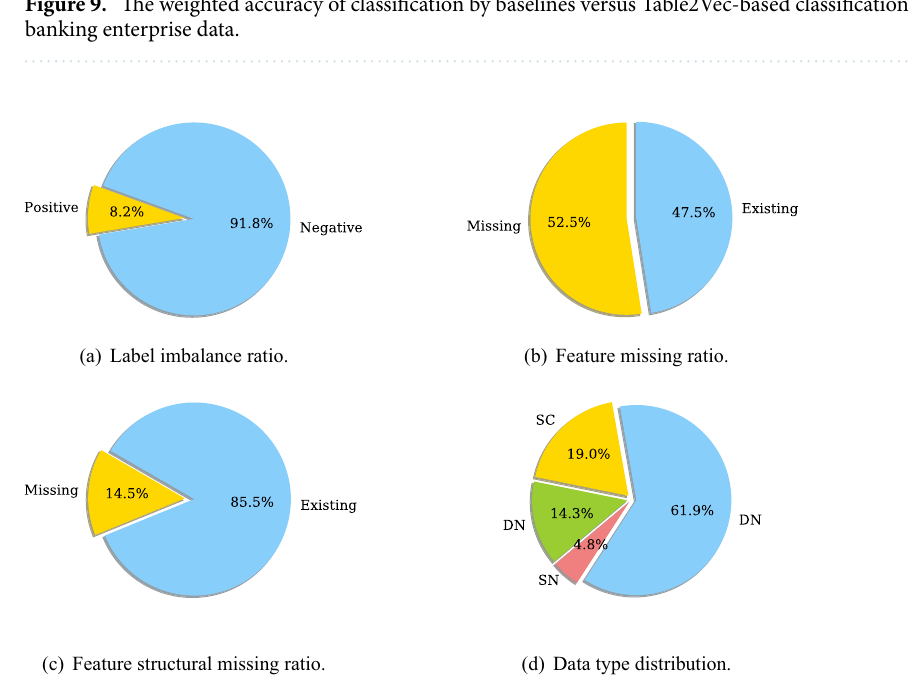
Figure 10. Data characteristics of a Kaggle data set. SC static categorical data, SN static numerical data, DC dynamic categorical data, DN dynamic numerical